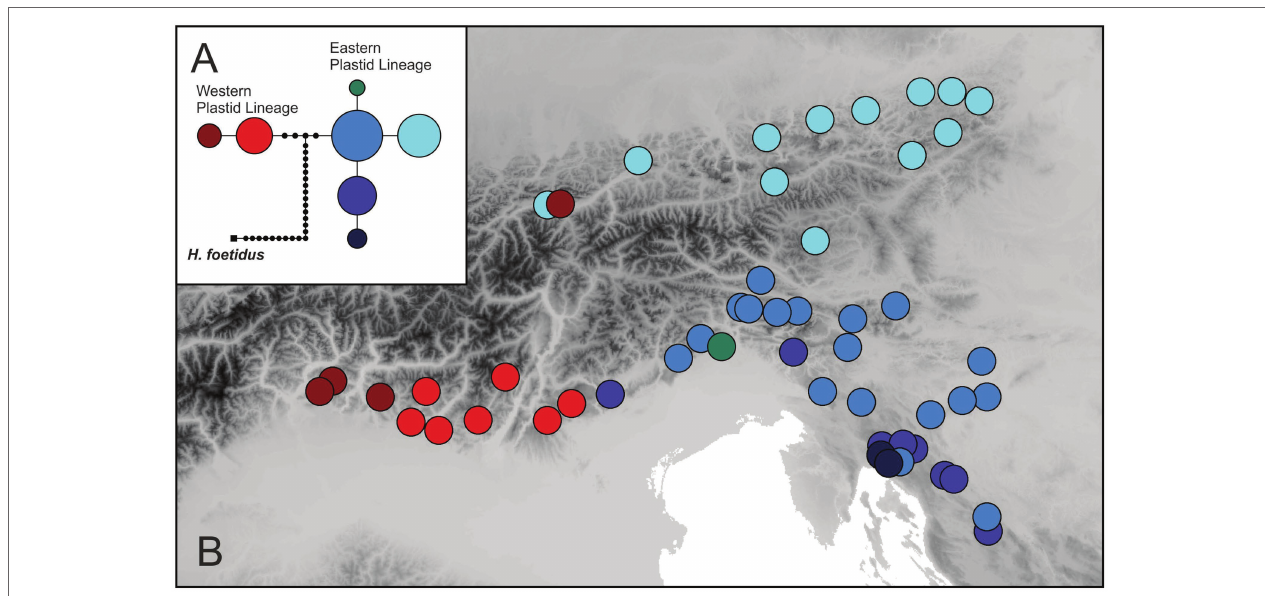
FIGURE 5 | Plastid DNA variation in H. niger based on partial sequences of the rpoB–psbM region . (A) Statistical parsimony network including the outgroup species H. foetidus . The size of a circle is relative to the square root of a haplotype’s frequency. Haplotypes not sampled are shown as small black dots. (B) Distribution of